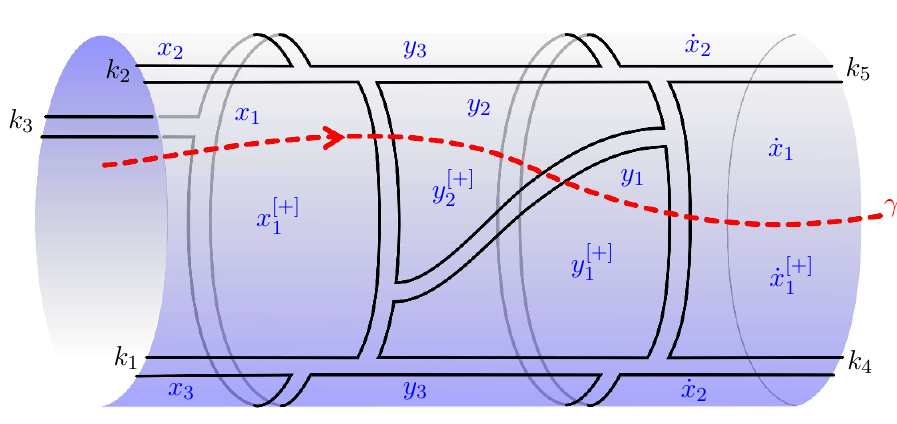
Figure 14 . To construct the cylinder integrand of the cylindrically cut double trace amplitude, one has to associate a set of dual coordinates with the faces of any Feynman diagram. Internal faces of the diagram are associated with loop integration variables y i and external ones with the dual coordinates x i . Circling around the cylinder in the direction of the ordering of the momenta on the (cid:12)rst trace results in a shift of the dual coordinates by q , y i ! y [+] f y i g L are then i =1